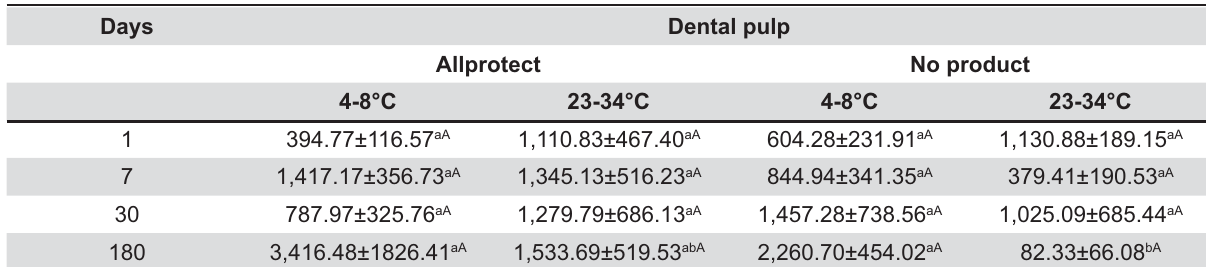
#(cid:22)(cid:12)(cid:14)(cid:14)(cid:4)(cid:10)(cid:4)(cid:6)(cid:9)(cid:2) (cid:27)(cid:13)$(cid:4)(cid:10)(cid:19)(cid:5)(cid:8)(cid:4)(cid:2) (cid:27)(cid:4)(cid:9)(cid:9)(cid:4)(cid:10)(cid:8)(cid:2) (cid:12)(cid:6)(cid:7)(cid:12)(cid:19)(cid:5)(cid:9)(cid:4)(cid:2) (cid:8)(cid:9)(cid:5)(cid:9)(cid:12)(cid:8)(cid:9)(cid:12)(cid:19)(cid:5)(cid:27)(cid:27)(cid:26)(cid:2) (cid:8)(cid:12)(cid:20)(cid:6)(cid:12)(cid:18)(cid:19)(cid:5)(cid:6)(cid:9)(cid:2) (cid:7)(cid:12)(cid:14)(cid:14)(cid:4)(cid:10)(cid:4)(cid:6)(cid:19)(cid:4)(cid:8)(cid:2) (cid:25)(cid:4)(cid:9)$(cid:4)(cid:4)(cid:6)(cid:2) (cid:19)(cid:13)(cid:27)(cid:17)(cid:21)(cid:6)(cid:8)%(cid:2) (cid:7)(cid:12)(cid:14)(cid:14)(cid:4)(cid:10)(cid:4)(cid:6)(cid:9)(cid:2) (cid:17)!!(cid:4)(cid:10)(cid:19)(cid:5)(cid:8)(cid:4)(cid:2) (cid:27)(cid:4)(cid:9)(cid:9)(cid:4)(cid:10)(cid:8)(cid:2) (cid:12)(cid:6)(cid:7)(cid:12)(cid:19)(cid:5)(cid:9)(cid:4)(cid:2)(cid:8)(cid:9)(cid:5)(cid:9)(cid:12)(cid:8)(cid:9)(cid:12)(cid:19)(cid:5)(cid:27)(cid:27)(cid:26)(cid:2)(cid:8)(cid:12)(cid:20)(cid:6)(cid:12)(cid:18)(cid:19)(cid:5)(cid:6)(cid:9)(cid:2)(cid:7)(cid:12)(cid:14)(cid:14)(cid:4)(cid:10)(cid:4)(cid:6)(cid:19)(cid:4)(cid:8)(cid:2)(cid:25)(cid:4)(cid:9)$(cid:4)(cid:4)(cid:6)(cid:2)(cid:27)(cid:12)(cid:6)(cid:4)(cid:8)& Table 2- (cid:2)(cid:3)(cid:4)(cid:5)(cid:6)(cid:2)(cid:5)(cid:6)(cid:7)(cid:2)(cid:8)(cid:9)(cid:5)(cid:6)(cid:7)(cid:5)(cid:10)(cid:7)(cid:2)(cid:7)(cid:4)(cid:11)(cid:12)(cid:5)(cid:9)(cid:12)(cid:13)(cid:6)(cid:2)(cid:13)(cid:14)(cid:2)(cid:9)(cid:15)(cid:4)(cid:2)(cid:16)(cid:17)(cid:5)(cid:6)(cid:9)(cid:12)(cid:18)(cid:19)(cid:5)(cid:9)(cid:12)(cid:13)(cid:6)(cid:2)(cid:13)(cid:14)(cid:2)(cid:20)(cid:4)(cid:6)(cid:13)(cid:21)(cid:12)(cid:19)(cid:2)(cid:22)(cid:23)(cid:24)(cid:2)(cid:25)(cid:26)(cid:2)(cid:10)(cid:4)(cid:5)(cid:27)(cid:28)(cid:9)(cid:12)(cid:21)(cid:4)(cid:2)(cid:29)(cid:30)(cid:31)(cid:2)(cid:12)(cid:6)(cid:2)(cid:9)(cid:15)(cid:4)(cid:2)(cid:20)(cid:10)(cid:13)(cid:17)!(cid:2)(cid:13)(cid:14)(cid:2)(cid:7)(cid:4)(cid:6)(cid:9)(cid:5)(cid:27)(cid:2)!(cid:17)(cid:27)!"(cid:2) samples 81-160 (ng/ μ